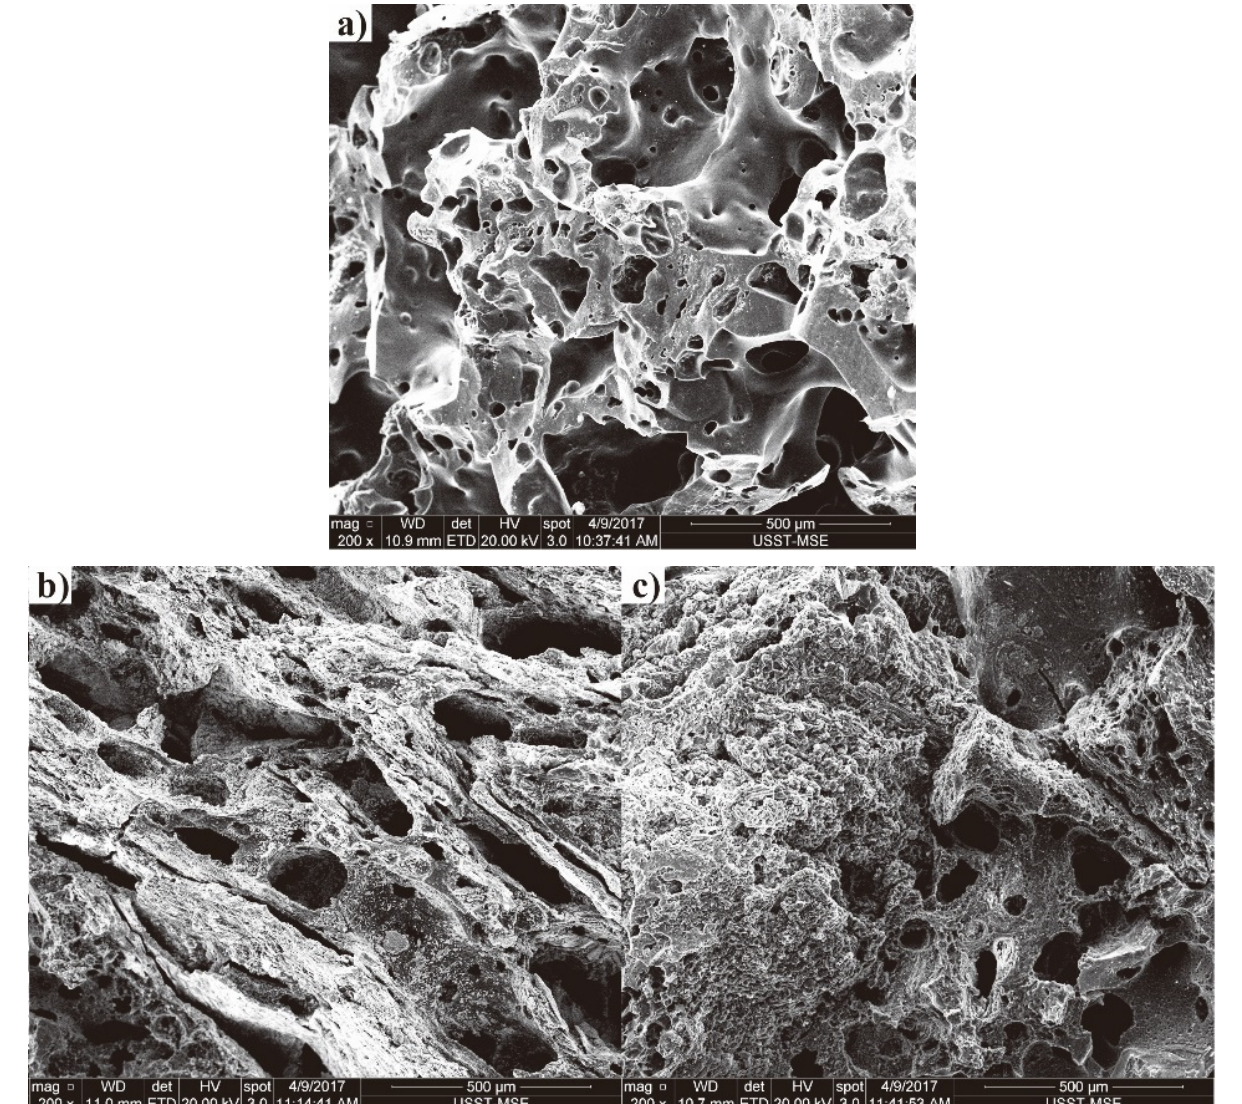
Figure 3. The SEM images of C2: ( a ) raw, ( b ) larger pores; ( c ) after reaction under T1 and T5.